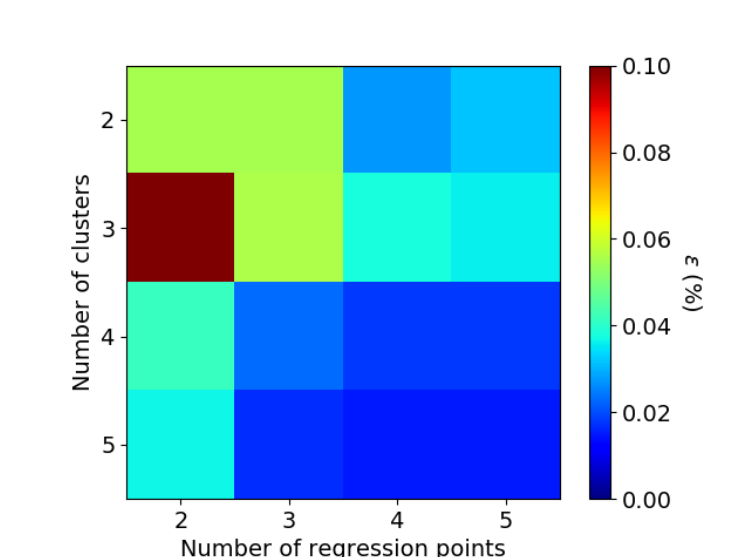
Figure 8. Dependence of the number of clusters and number of regression points with the mean error in percentage for the CO 2 band for the ‘Aerosol 2’ scenario. The low-stream model used is the two-stream